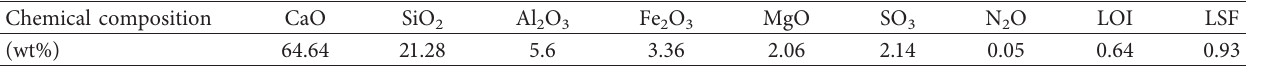
Table 1: Chemical composition of ordinary Portland cement. Chemical composition